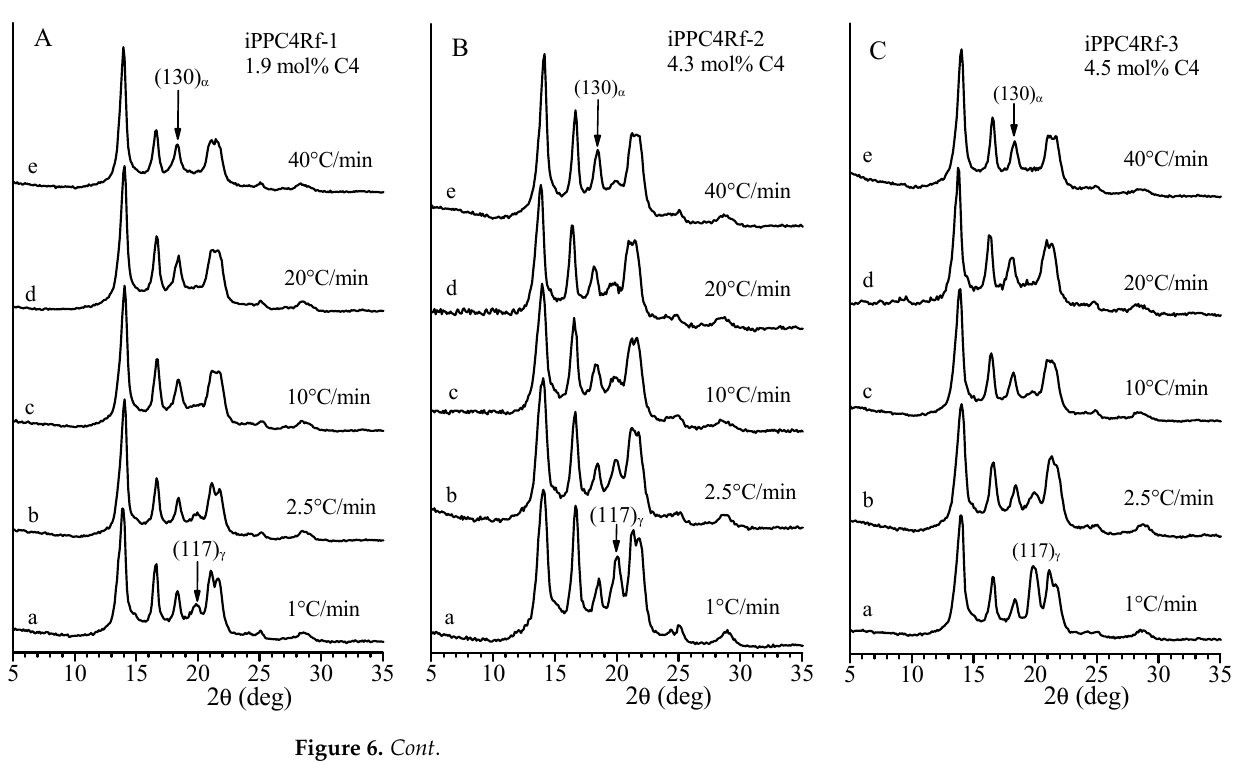
Figure 5. DSC cooling curves recorded at 10 °C/min of samples of iPPC4 copolymers of the indicated butene concentration after melting at 170 °C (Figure 3). Isotactic samples iPPC4Rf-x with [ rr ] < 0.1 mol% ( A ) and less isotactic samples iPPC4Z4-x with [ rr ] = 2.0–2.4 mol% ( B ) and iPPC4Z9-x with [ rr ] = 2.5–3.4 mol% ( C ).